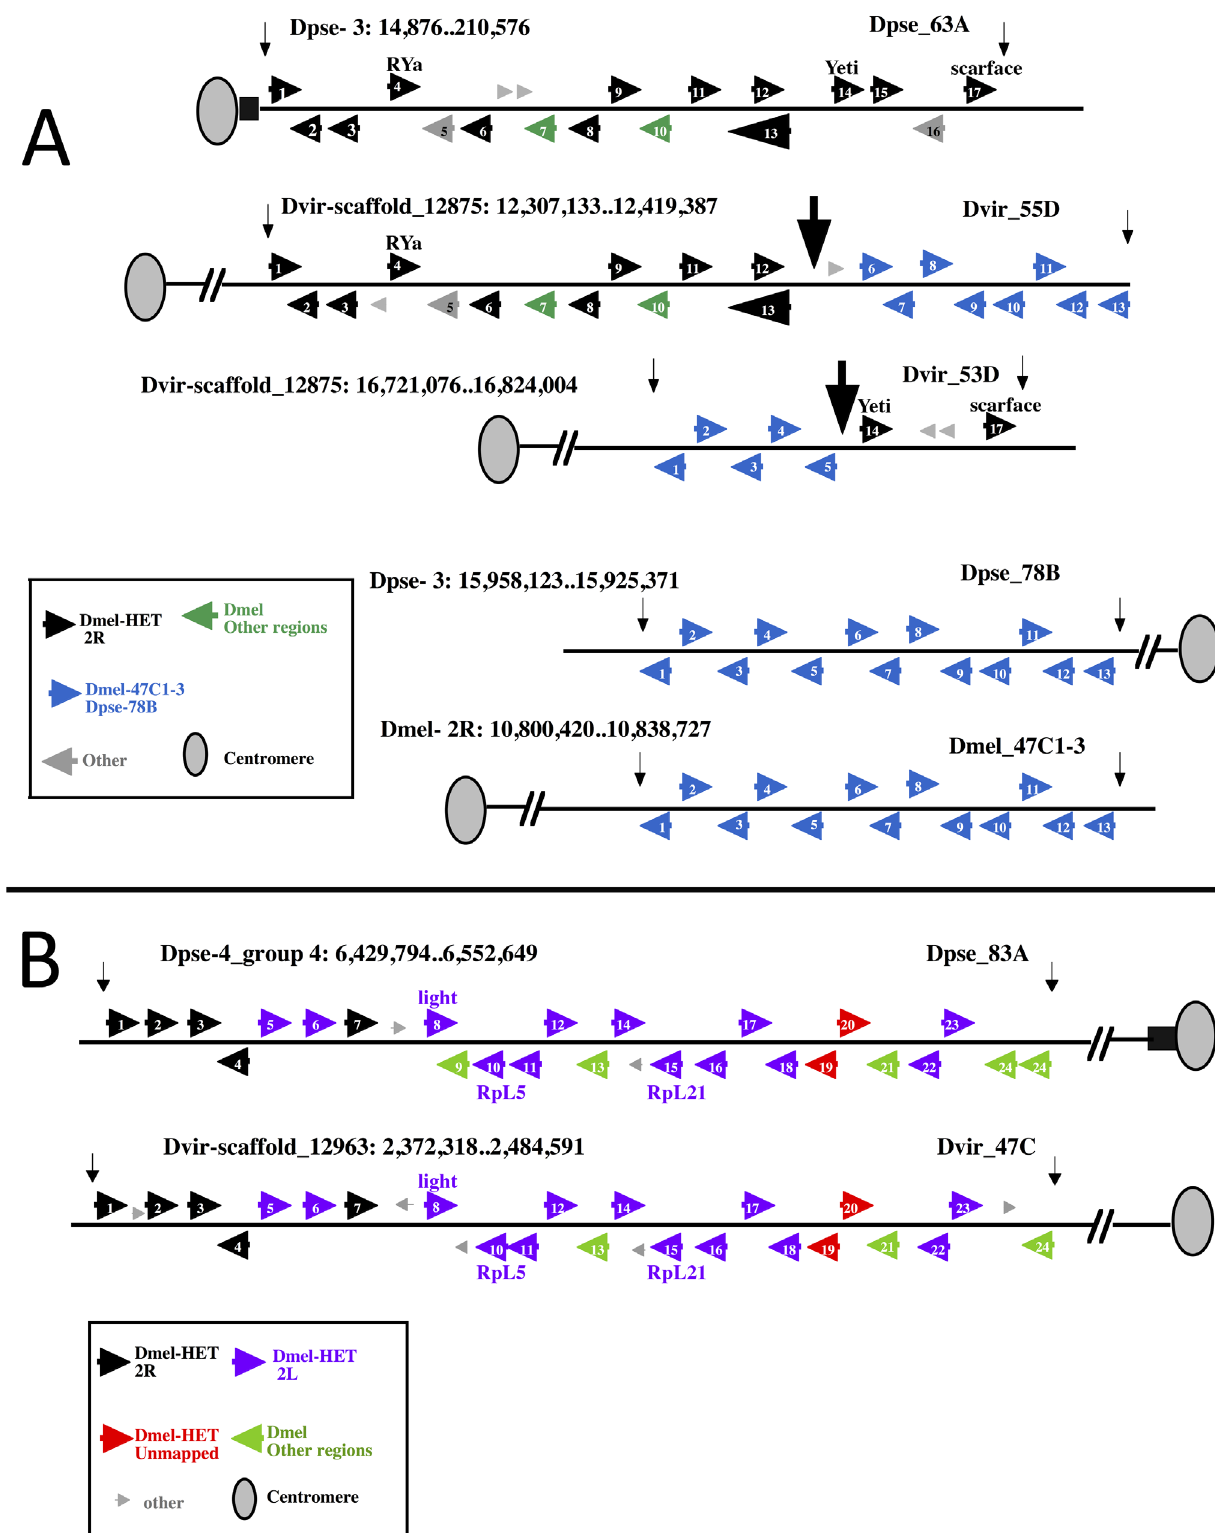
Fig 5. Syntenic relationships of gene clusters. (A) Syntenic relationships between Dpse_63A, Dvir_55D and Dvir_53D regions. Genes are depicted as arrowheads showing the transcription orientation and coloured according to their localization in D . melanogaster (box).